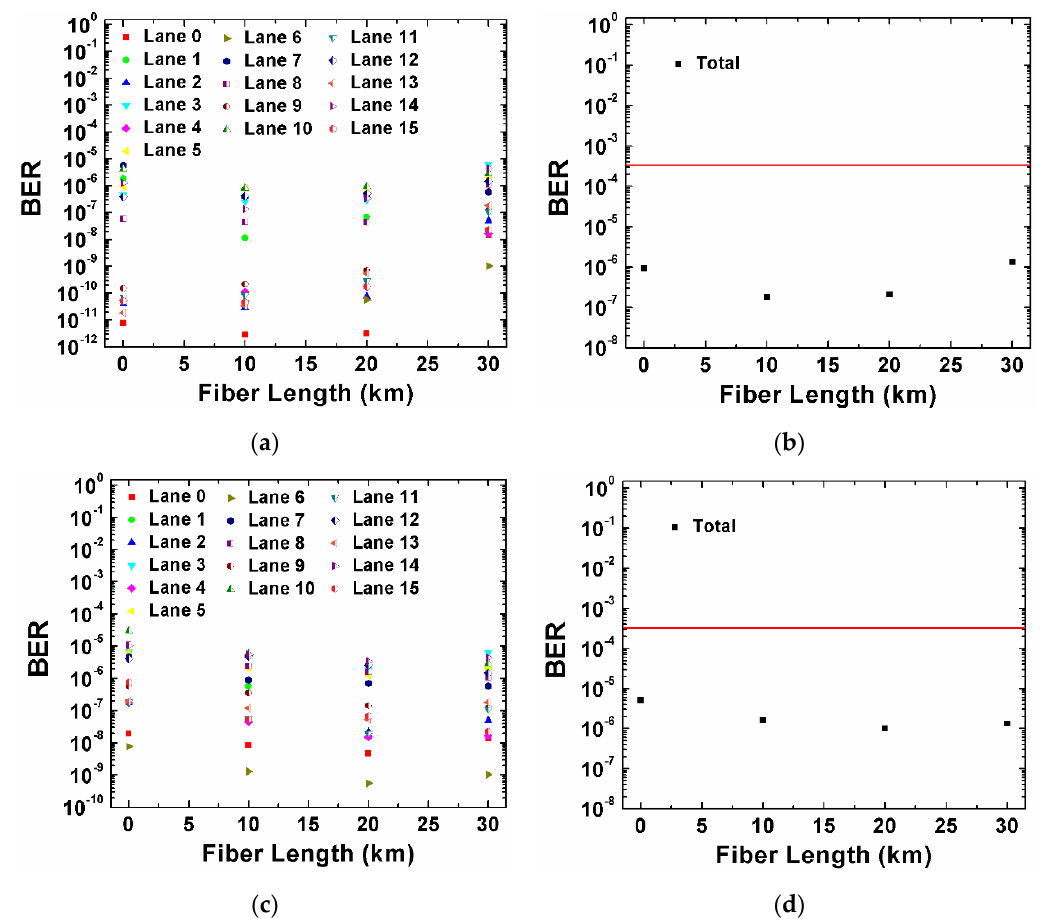
Figure 11. Interoperation of two CFP8-LR8 modules through single mode fiber (SMF) spool. The signal is transmitted from the Tx of the first module to the Rx of the second module: ( a ) BER vs. fiber length for 16 individual electrical lanes; ( b ) total BER vs. fiber length. The signal is transmitted from the Tx of the second module to the Rx of the first module: ( c ) BER versus VOA2’s attenuation for 16 individual electrical lanes; ( d ) total BER vs. VOA2’s attenuation. The threshold for the UCW is shown as the red line.